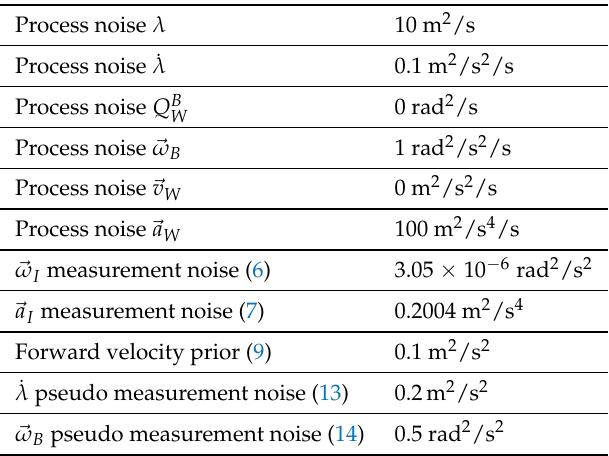
Table A1. Ref. [11] Covariances of the initial guess.